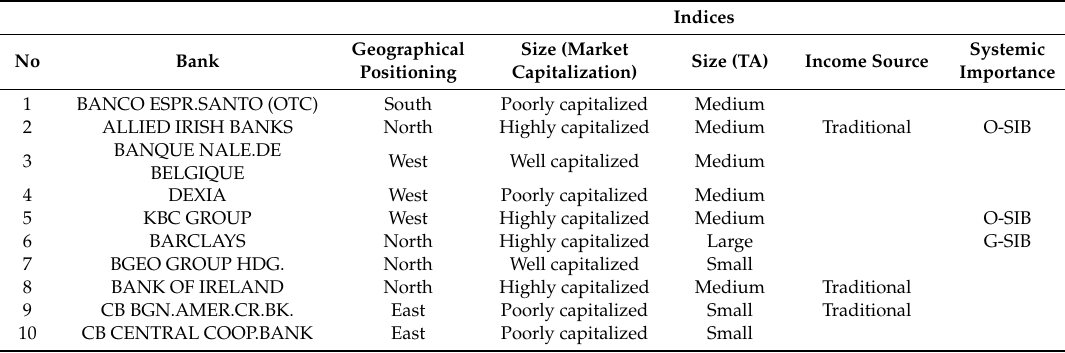
Table A1. The list of the banks included in the sample, particularly in each